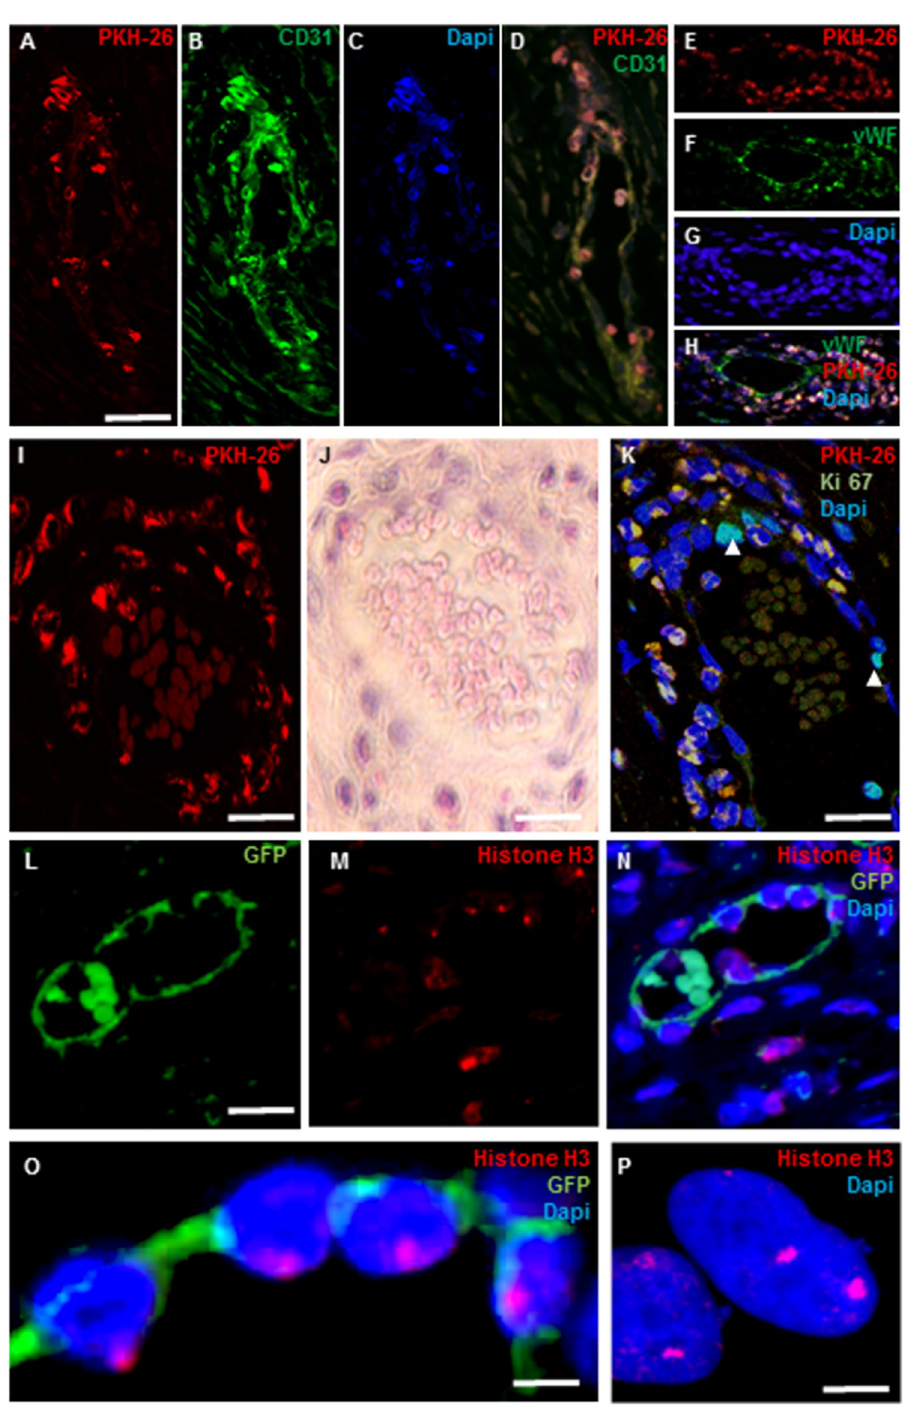
Fig 4. Systemically transplanted MSCs form blood vessel structures on day 30 after transplantation. Confocal microscopy showed that at thirty days after transplantation, PKH-26 transplanted cells (red) were organized in blood vessels-like structures (A) and were expressing CD31 (B). Nuclei are counterstained with DAPI (C). A merged image showing the co- localization of PKH-26 and CD31 is shown in (D). PKH-26 transplanted cells, organized in a capillary like structure (E), decorated with anti-vWF are demonstrated in (F). Nuclei are counterstained with DAPI (G). A merged image showing co-localization of PKH-26 and vWF (H). An example of a blood vessel composed of PKH-26 labeled cells is seen in (I). H&E staining of an adjacent section demonstrates the existence of enucleated erythrocytes